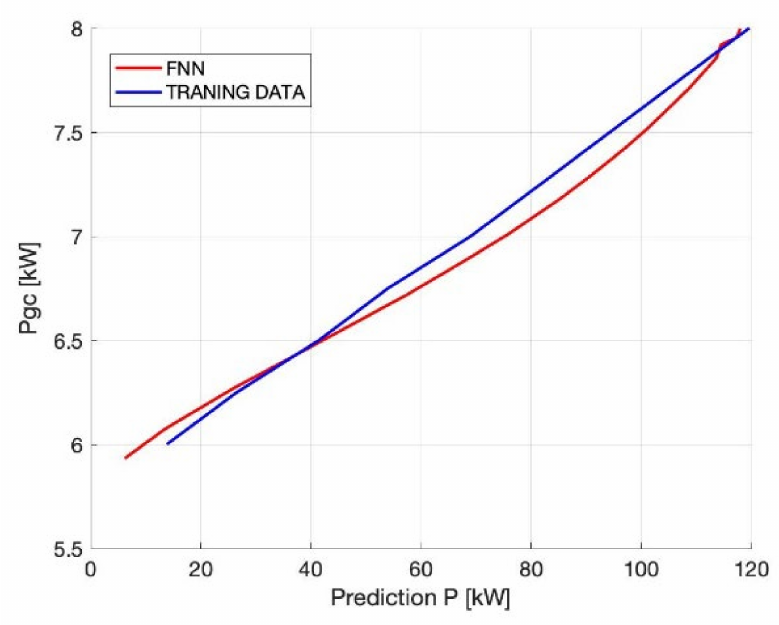
Figure 24. Compilation of the training data with the machine response, scenario